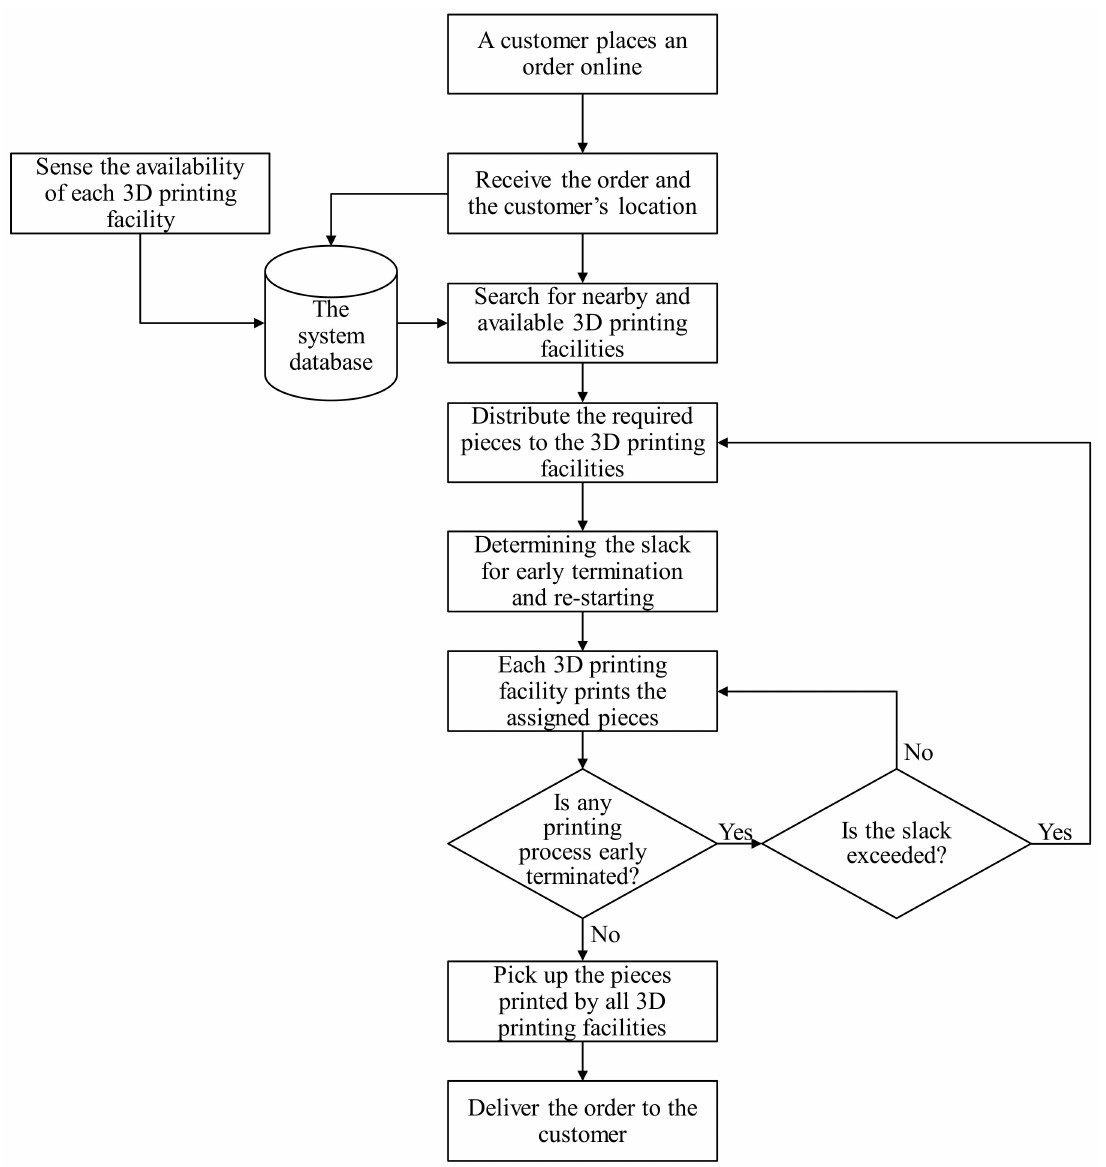
Figure 1. The operational procedure of the collaborative and ubiquitous additive manufacturing